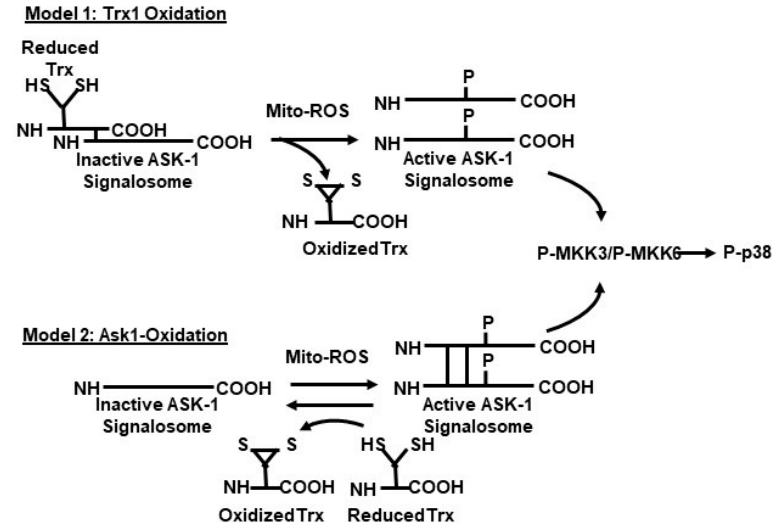
Figure 4. Two proposed model of the mechanism of activation of the ASK1 ROS-Sensory complex Model 1: The Tri-oxidation model —The (SH) 2 Trx-ASK1 complex serves as a negative regulator of ASK1 and the association of (SH) 2 Trx with ASK1 maintains the signalosome in an inactive state. The signalosome is activated by dissociation of oxidized Tri. Model 2: ASK-oxidation model —ASK1 Monomers are activated by ROS-mediated multimerization (disulfide bond formation). Inactivation